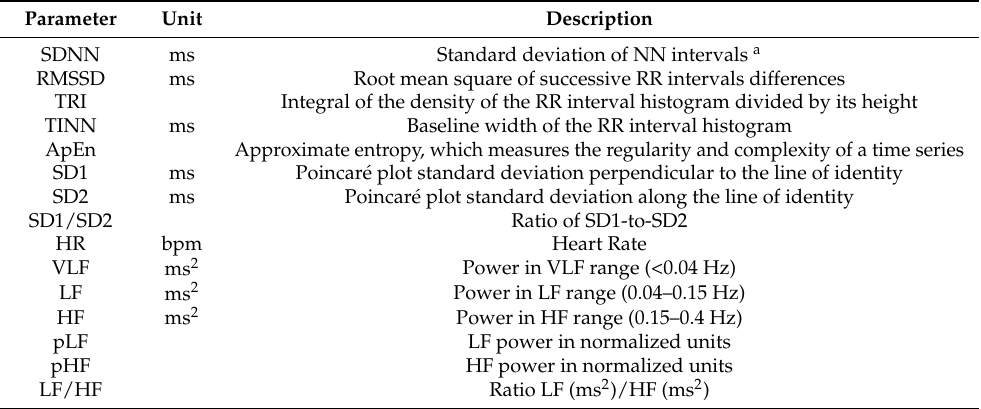
Table 1. HRV indices based on IBI